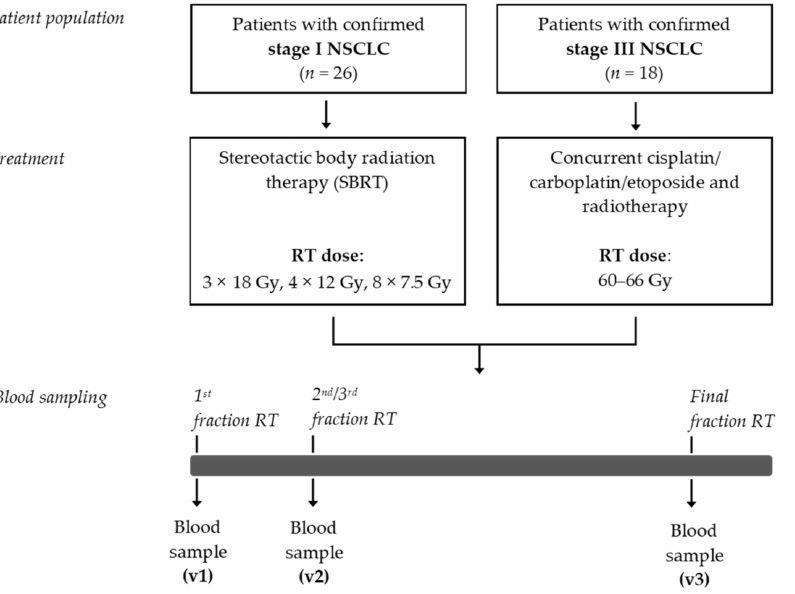
Figure 1. Study design. NSCLC, non-small cell lung cancer; RT, radiotherapy; SBRT, stereotactic body